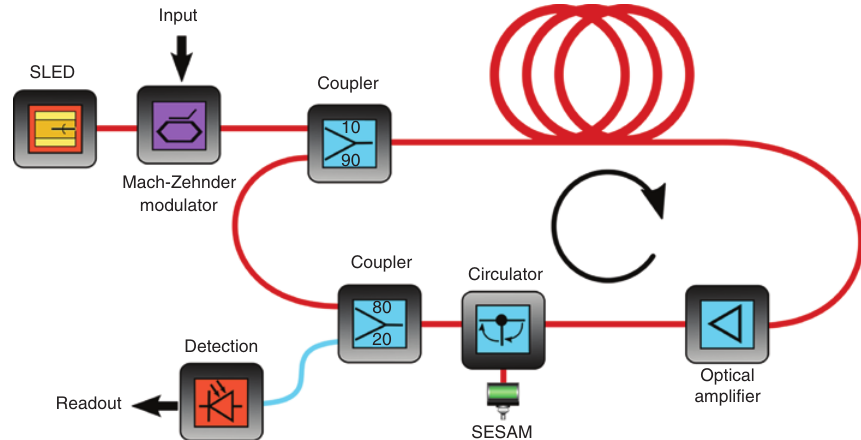
Figure 10: Scheme of the all-optical reservoir computer based on the saturation of absorption. The input optical signal is injected into the ring cavity by means of a fiber coupler. The cavity itself consists of a fiber spool used as a delay line, an optical amplifier, a circulator, and a SESAM. A fiber coupler is used to send 20% of the cavity intensity to the readout